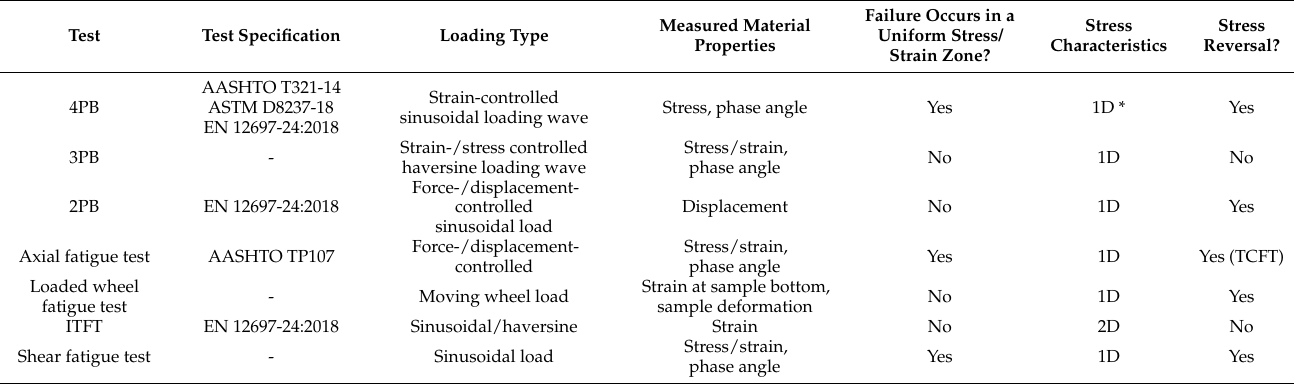
Table 2. Summary of fatigue test